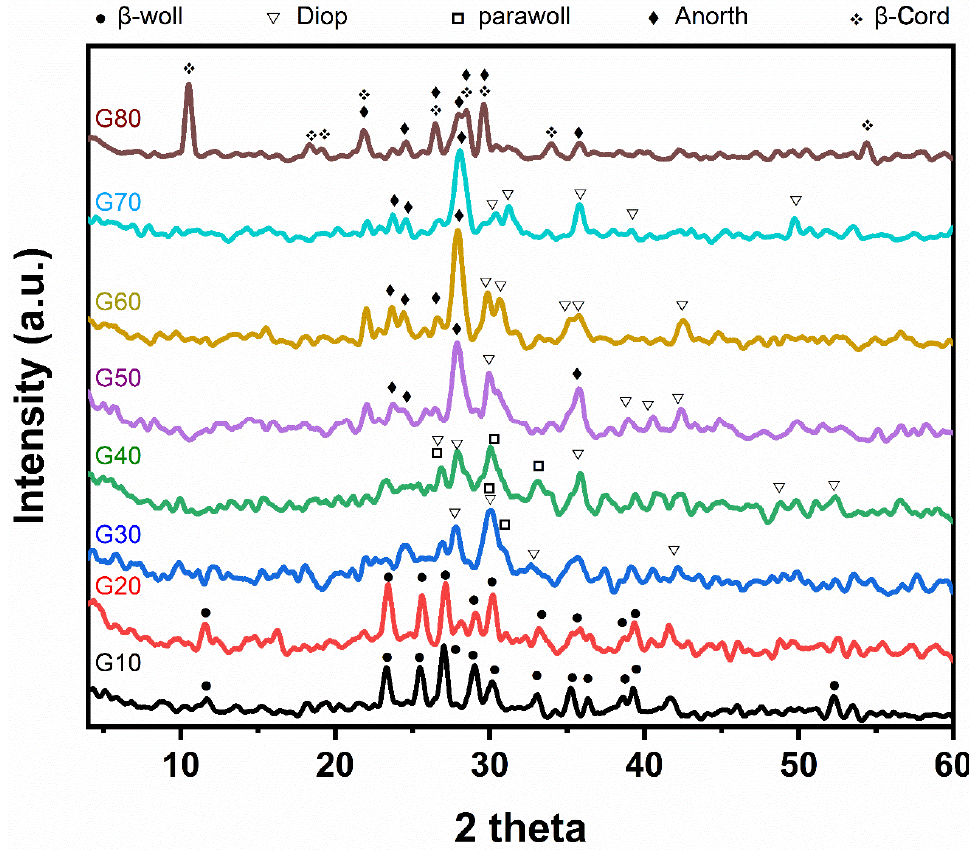
Figure 3. X-ray diffraction patterns of the investigated samples based on by-pass cement dust after Figure 3. X ‐ ray diffraction patterns of the investigated samples based on by ‐ pass cement dust after heat ‐ treatment at 1000  C for 2 h. heat-treatment at 1000 ◦ C for 2